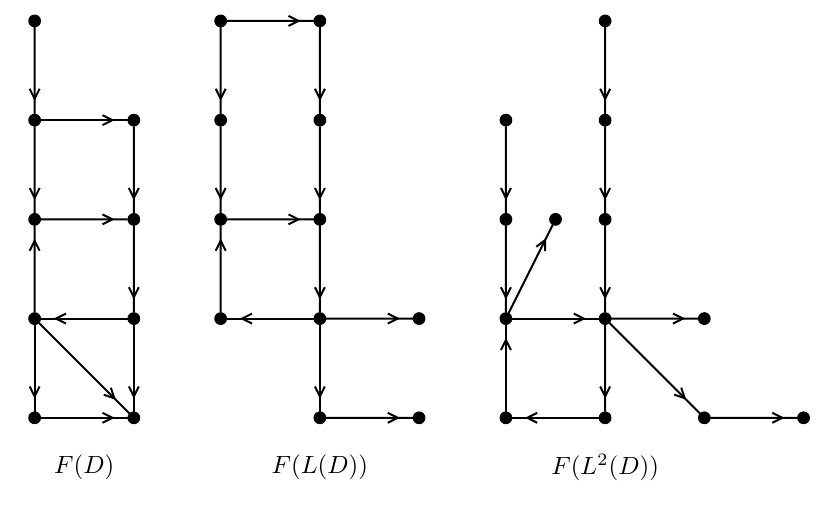
Figure 20: The foundations of iterated line digraphs.